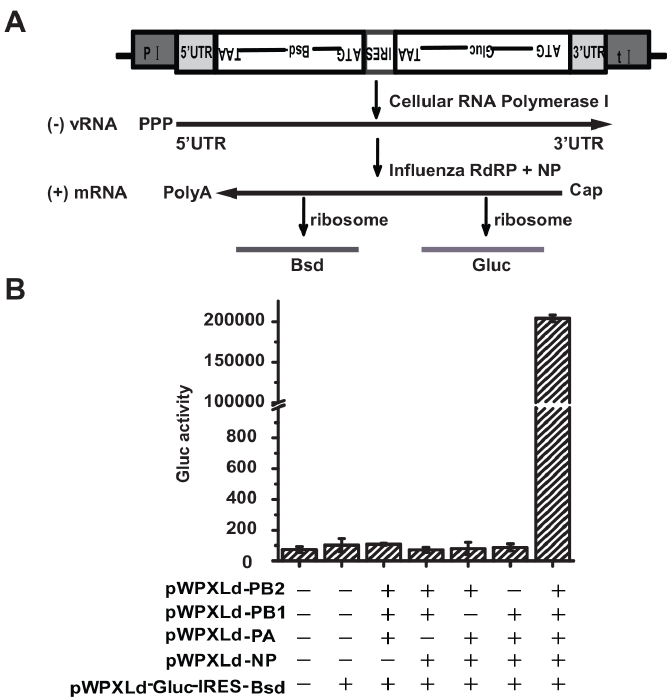
Fig 1. Construction of Gluc/Bsd reporter system driven by influenza RdRp. (A) Schematic representation of Gluc/Bsd reporter system. Gluc/Bsd reporter construct comprises Gluc open reading